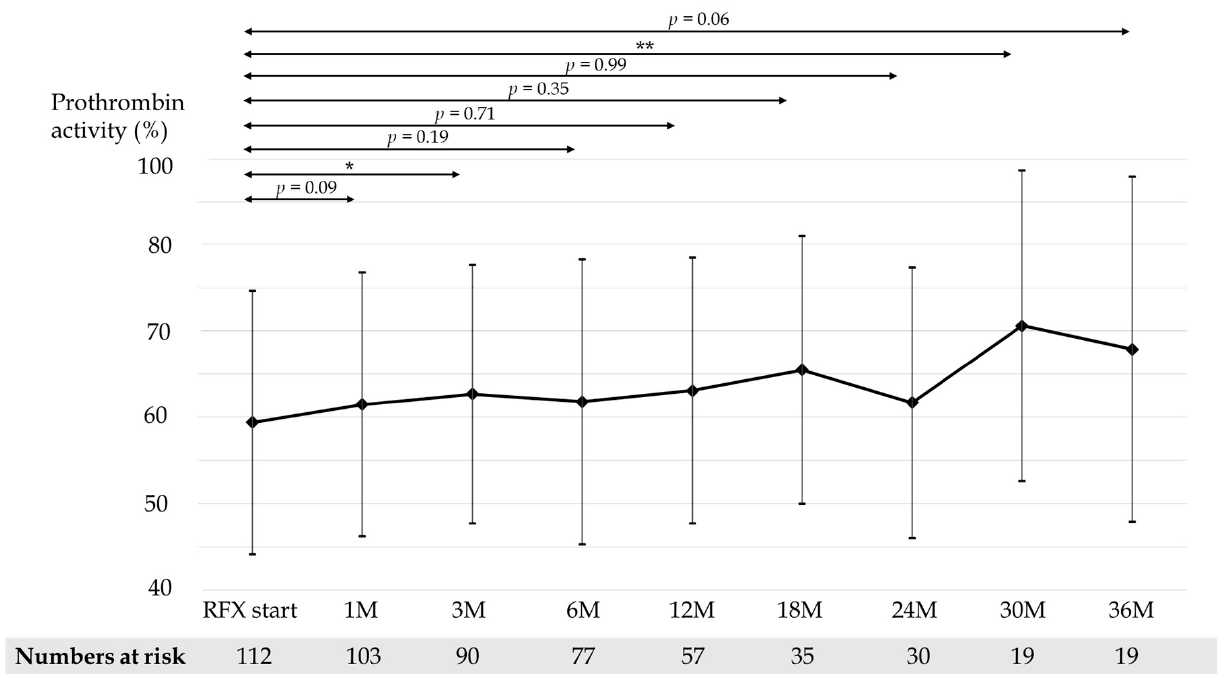
Figure 5. Changes in mean prothrombin activity before and 1, 3, 6, 12, 18, 24, 30, and 36 months after RFX administration. p -values were determined using the Wilcoxon signed-rank test ( p < 0.1 tendency differences, p < 0.05 *, p < 0.01 **). RFX, rifaximin.